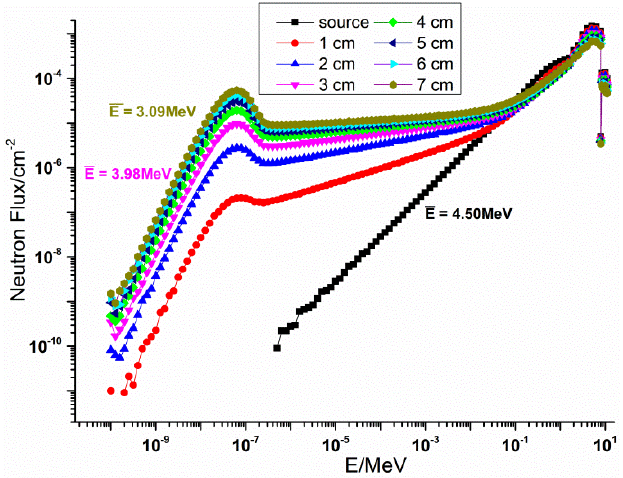
Figure 3. Energy spectrum and average energy of the 241 Am–Be neutron source moderated by polyethylene layers with different thicknesses.